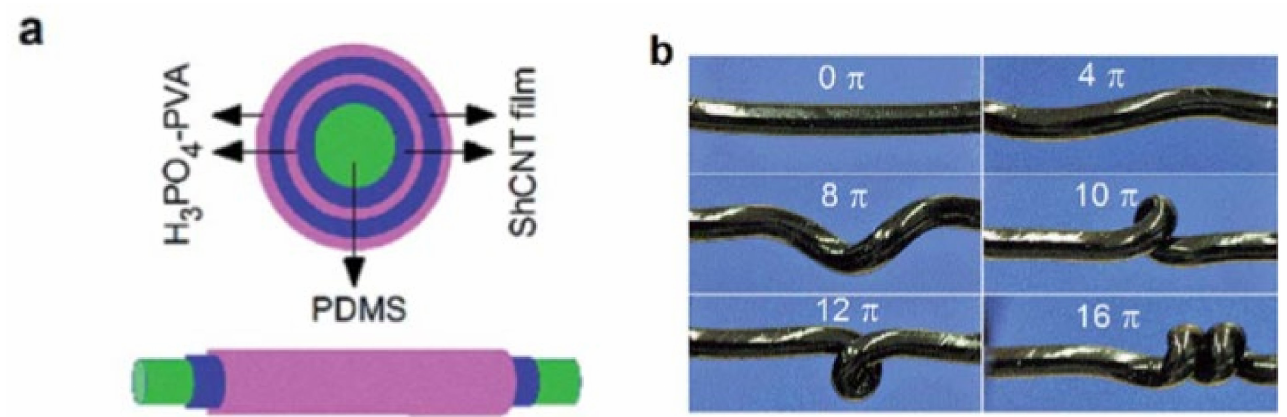
Figure 14. ( a ) The structure of a torsionable supercapacitor in cross-sectional and side views. ( b ) Digi- tal photos showing the supercapacitor at different torsion levels. Reprinted with permission from [85].